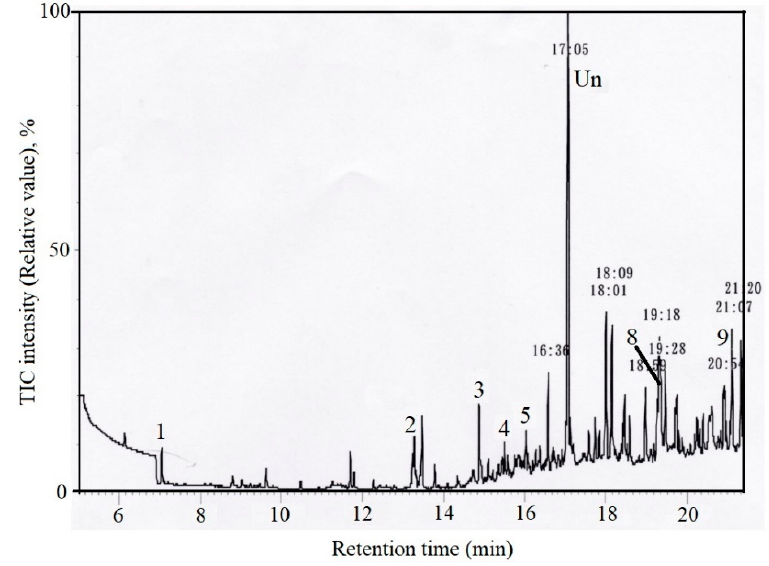
Figure 4. TIM-GC/MS chromatograms of the sample extracted from sand in Waikiki beach, Hawaii, Figure 4. TIM-GC / MS chromatograms of the sample extracted from sand in Waikiki beach, Hawaii, 21°16 ′ N, 158°8 ′ E, Date: 25 March 1975. 21 ◦ 16 (cid:48) N, 158 ◦ 8 (cid:48) E, Date: 25 March